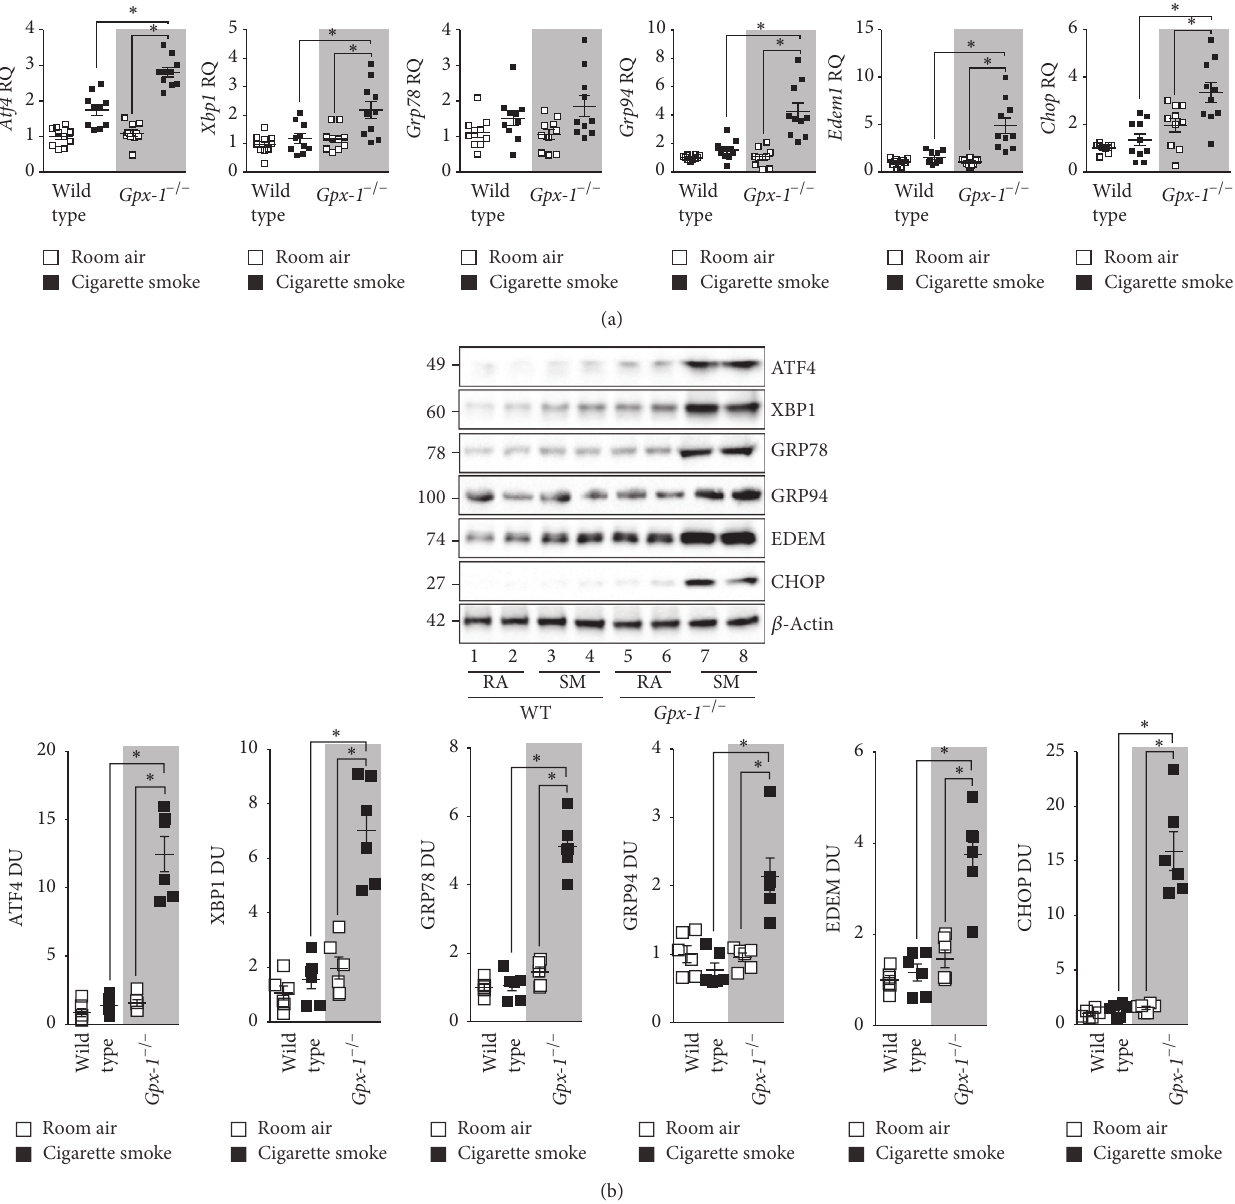
Figure 5: Gpx-1 deficient mice have heightened ER stress in their lungs following exposure to cigarette smoke. Gpx-1 −/− and wild type mice were exposed to cigarette smoke daily for 1 year. (a) Lung gene expression of Chop , Atf4 , Edem1 , Grp78 , Grp94, and Xbp1 was examined. (b) Immunoblots were performed of whole lung protein for CHOP, ATF4, EDEM, GRP78, GRP94, and XBP1. Dot plots are represented as (a) relative quantification (RQ) compared to ACTB expression or (b) densitometry units (DU) of pixel intensity expressed as a ratio to 𝛽 -actin. Every lane represents an individual mouse. Data are shown as mean ± SEM, where each measurement was performed on 3 independent days on 6 donors/group. ∗ denotes a 𝑝 value < 0.05, when comparing both treatments connected by a line, determined by 2-way ANOVA with Tukey’s post hoc test ( > 2